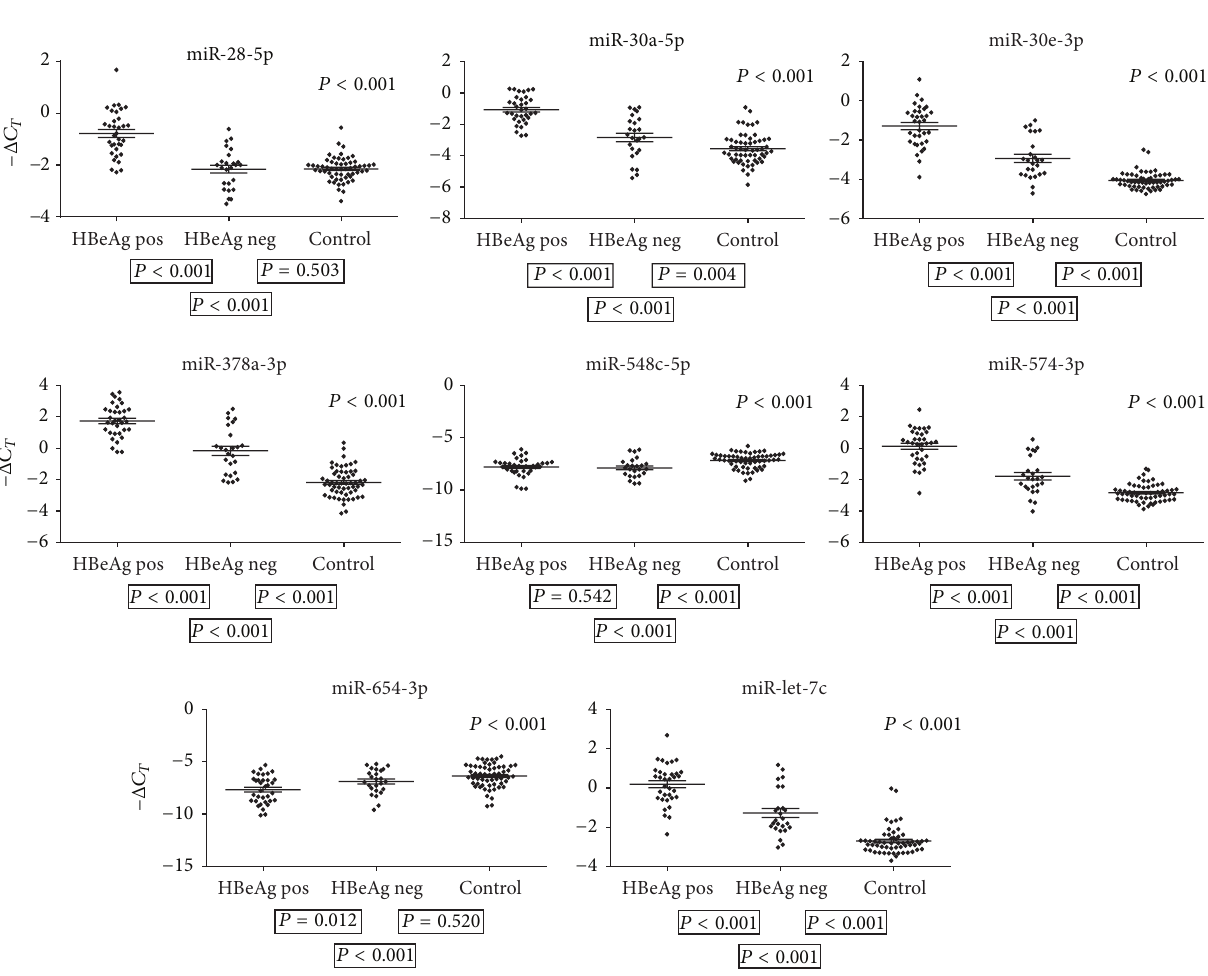
Figure 1: MicroRNA plasma levels in HBeAg-positive, HBeAg-negative, and healthy children. qRT-PCR-data on 34 HBeAg-positive, 25 HBeAg-negative, and 57 healthy control children. The 𝑃 values shown above the individual figures are results of statistical analyses on HBeAg- positive, HBeAg-negative, and healthy children, and 𝑃 values shown below left are results on HBeAg-positive versus HBeAg-negative, below centred HBeAg-positive versus healthy controls, and below right HBeAg-negative versus healthy controls. The bars represent geometric means −Δ𝐶 𝑇 ± SEM. Due to multiple testing only 𝑃 < 0.0028 was considered